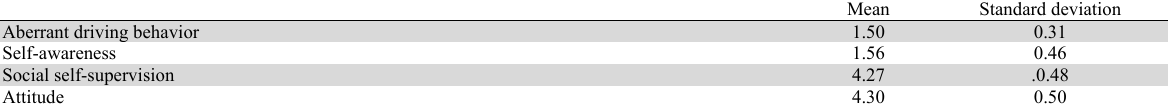
The means and standard deviations of driving attitude, self-awareness, social self-supervision, and deviant behavior